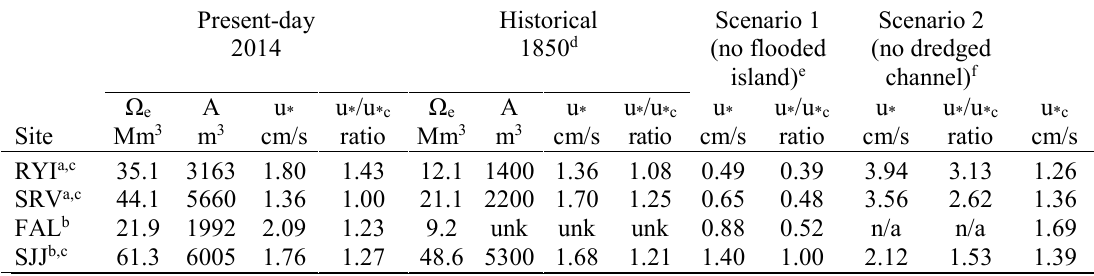
Table 2 Measured median discharge, and calculated shear velocity compared to estimated median discharge and shear velocity assuming the absence of an upstream flooded island; calculated critical shear velocity for these sites is also